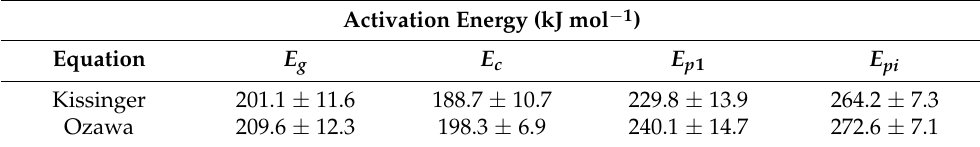
Figure 4. ( a ) Kissinger plots of ln( T 2 / β ) versus 1000/ T and ( b ) Ozawa plots of ln( β ) versus 1000/ T for the S8 amorphous samples. Table 3. The calculated apparent activation energy of the S8 amorphous samples by different meth- ods.